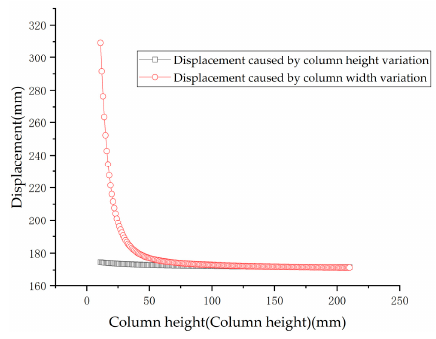
Figure 8. Sensitivity curve of C C plate thickness.